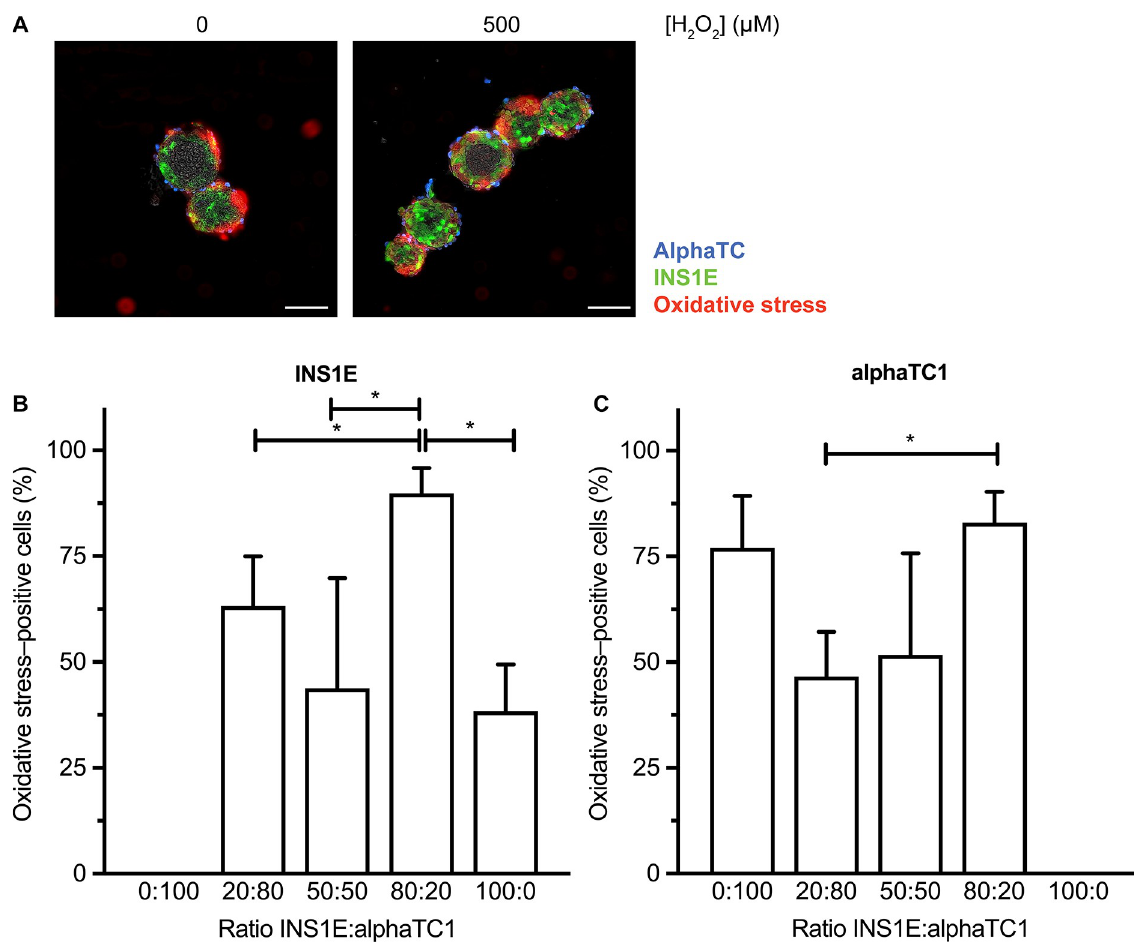
oxidative stress–positive INS1E cells. C) Seeding INS1E and alphaTC1 in the ratio 20:80 in 3D aggregates exposed to 500 μ M H 2 O 2 decreased the percentage of oxidative stress–positive alphaTC1 cells compared to seeding 3D aggregates in the ratio 80:20 INS1E:alphaTC1. N = 3, n � 2 and data are presented as mean ± SEM; � p � 0.05, all p-values are shown in S8 and S9